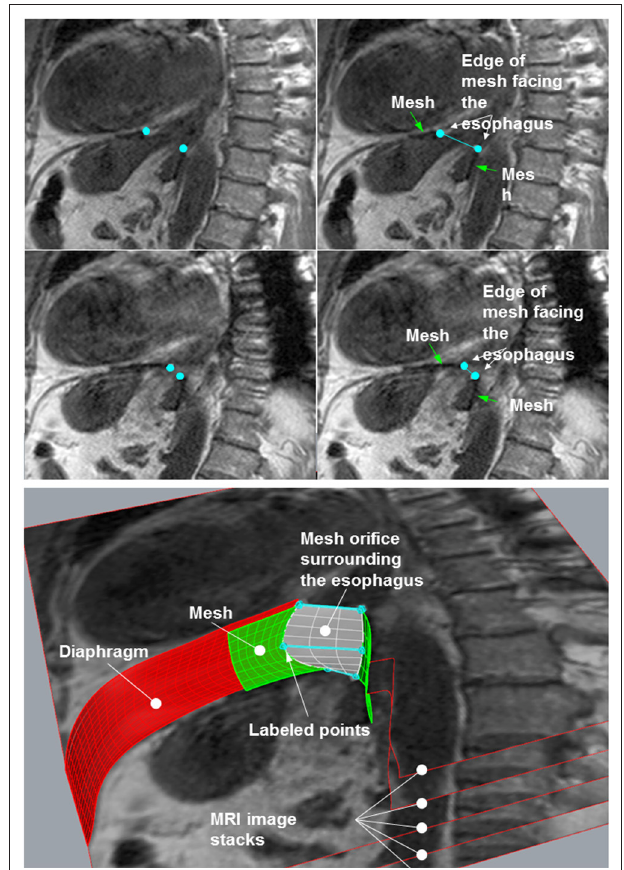
FIGURE 2 | (Upper) Two images from one sequence used for analysis. Left column: the mesh edge closest to the esophagus was labeled using ImageJ (small, light gray square dots). These images were saved for control purposes. Right column: the same images with descriptions. (Lower) Calculation of the mesh orifice by stacking the images and generating a skewed plane between the marked